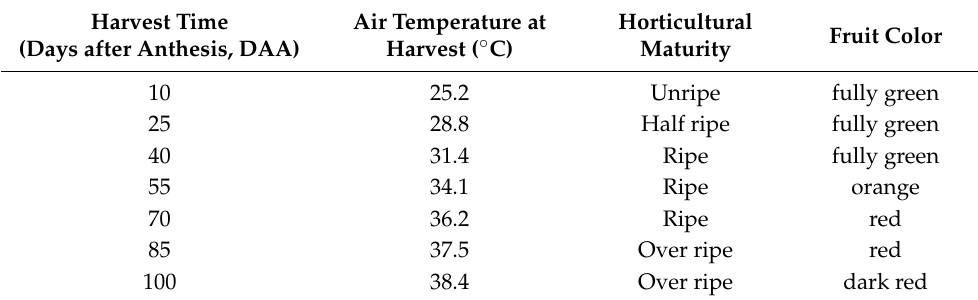
Table 1. Air temperature at harvest, fruit maturity and color of the eleven Tunisian chili pepper accessions at each harvest